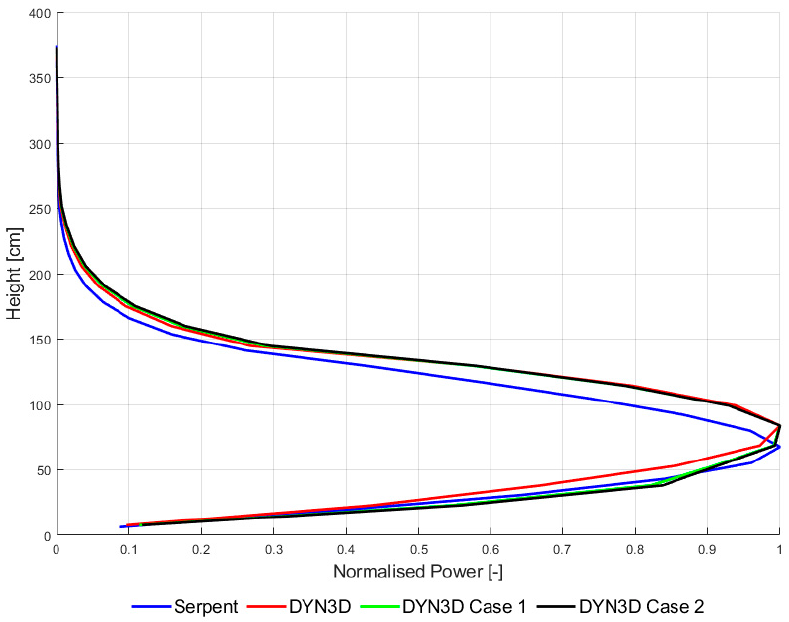
Figure 13. New power density profiles with the additional levels added to DYN3D.